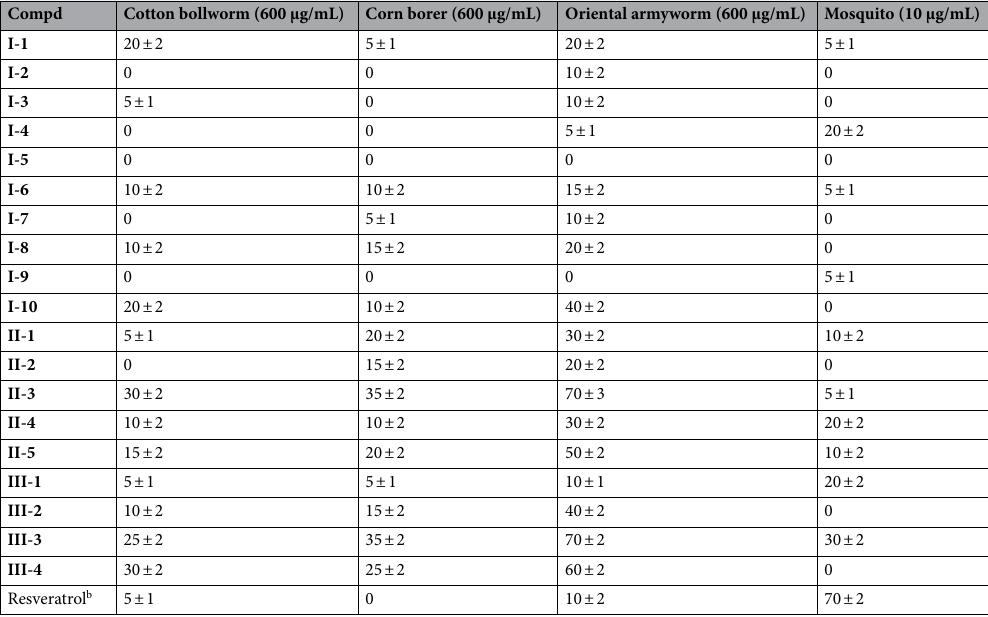
Table 3. Insecticidal activities of the target compounds I-1–I-10 , II-1–II-5 and III-1–III-4 (mortality a , percent). a Average of three replicates. All results are expressed as the mean ± standard deviation (SD). b Positive